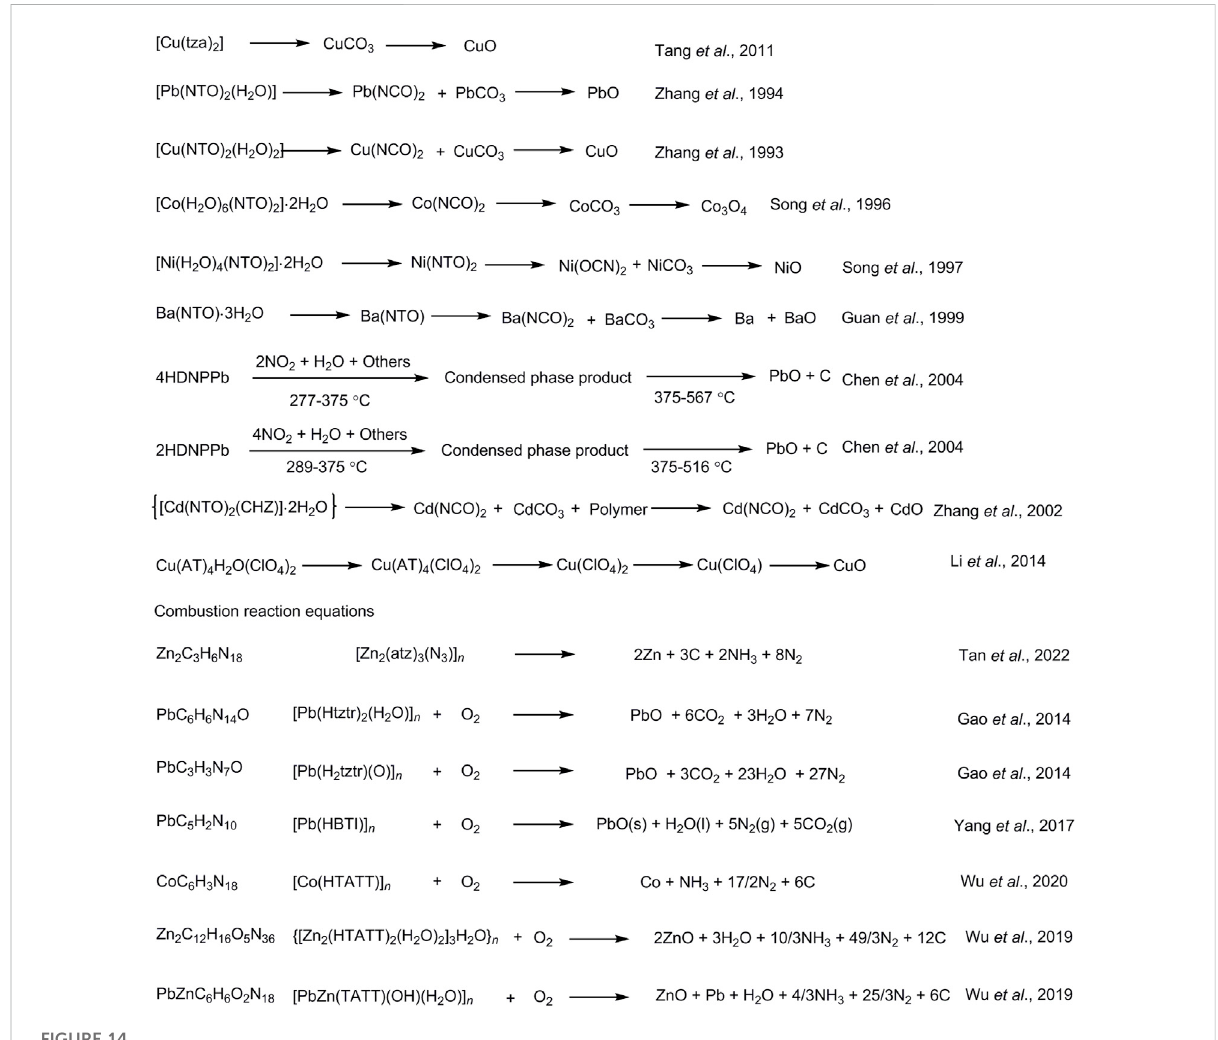
FIGURE 14 Diagram of catalytic combustion mechanism of typical